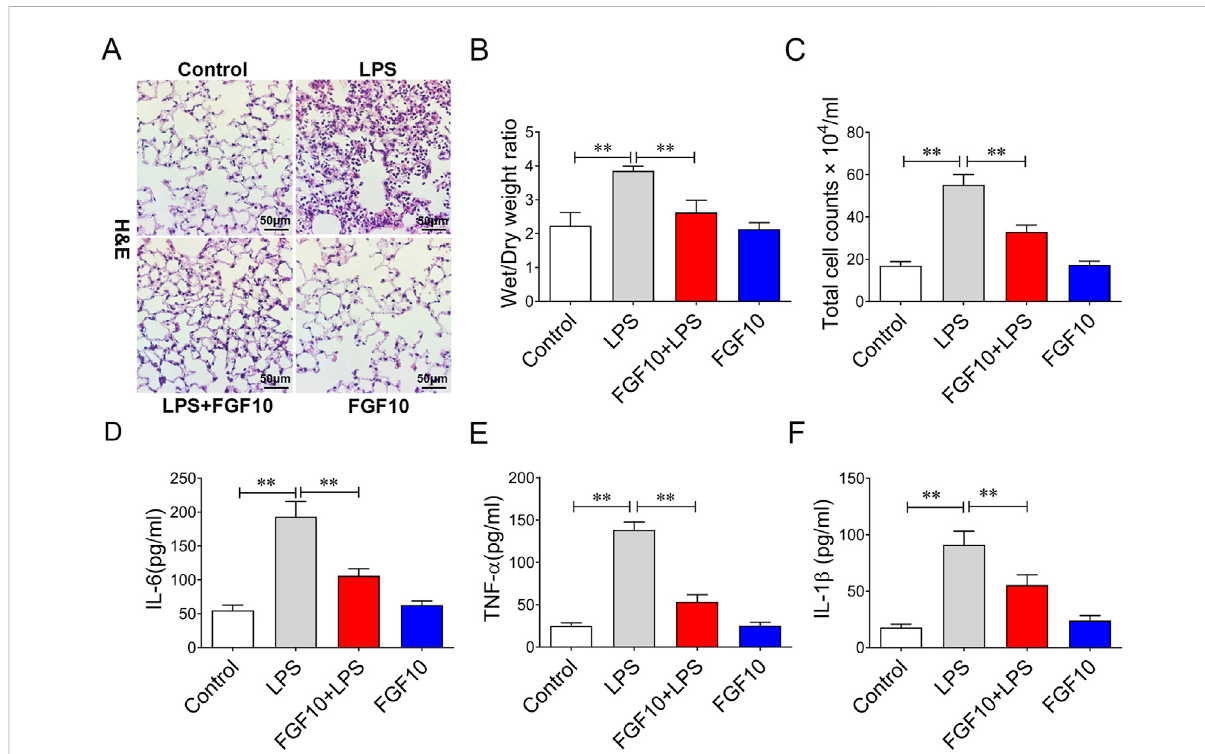
FIGURE 2 FGF10 attenuates LPS-induced structural damage and in fl ammatory mediator production in mice. (A) Pathological change in lung tissue was detected by H&E (200×). (B) Quantitative analysis of wet/dry weight ratio. (C) BAL fl uid was obtained to differentially count total cells. (D – F) The expression of IL-6, TNF- α , and IL-1 β in BALF were determined by ELISA. The data were presented as the mean ± SEM, n = 5. * p < 0.05, * * p <